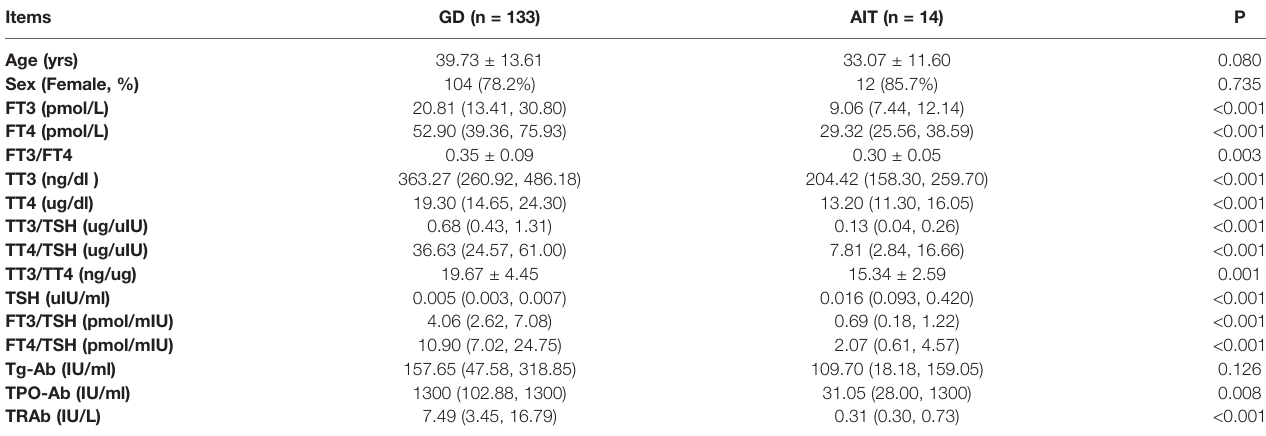
TABLE 2 | Clinical characteristics of patients with Graves ’ disease and those with autoimmune thyroiditis in Cohort 2.